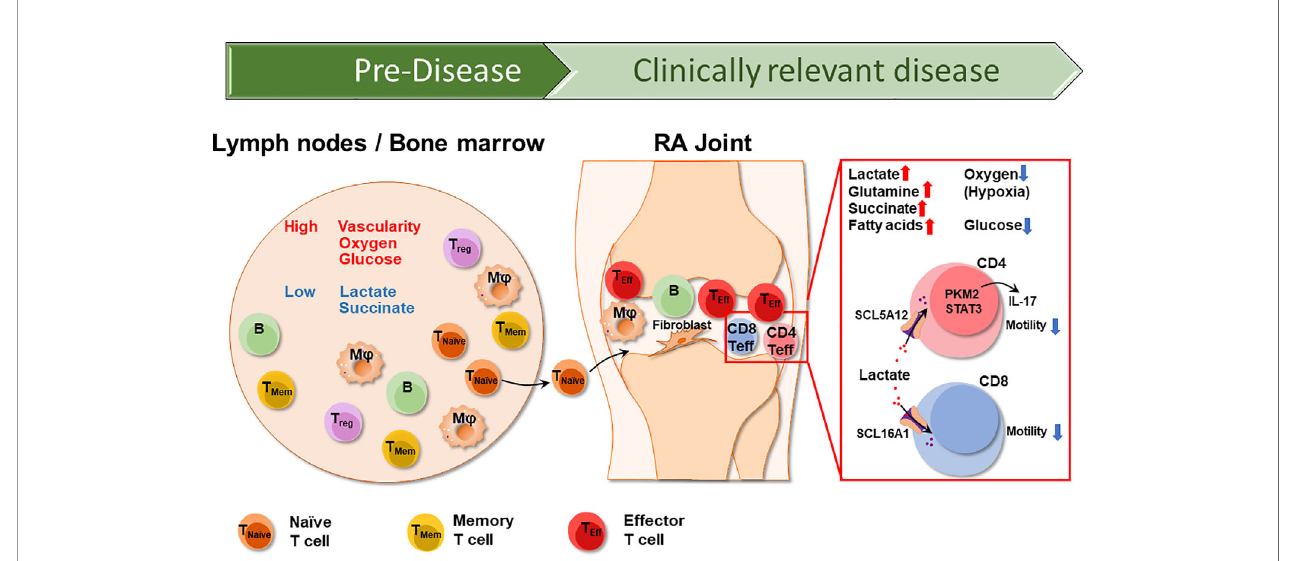
FIGURE 1 | The different Tissue Environments of Rheumatoid Arthritis. Early events in the RA disease process, e.g., the loss of self-tolerance of RA T cells occurs in lymphoid tissues, such as lymph nodes and the bone marrow. Over lifetime, lymphoid tissues remain the home of naïve and memory T cells, which circulate through the peripheral blood where they can be sampled. Lymph nodes are highly vascularized, therefore have access to oxygen and glucose. As RA naïve T cells differentiate into short lived effector T cells (SLEC), they acquire the ability to leave the circulation and invade into the synovial tissue. Synovial effector T cells encounter a different metabolic environment which is hypoxic, low in glucose and high in lactate due to the chronic activation of macrophages and stromal cells. CD4 + effector T cells and CD8 + effector T cells uptake lactate through SCL5A12 and SCL16A1, respectively. Imported lactate promotes IL-17 secretion in CD4 + T cells and inhibits both CD4 + and CD8 + T cell motility, essentially arresting T cells in the lactate hi synovium. T naïve , naïve T cell; T Mem , memory T cell; T reg , regulatory T cell; M j , macrophage; B, B